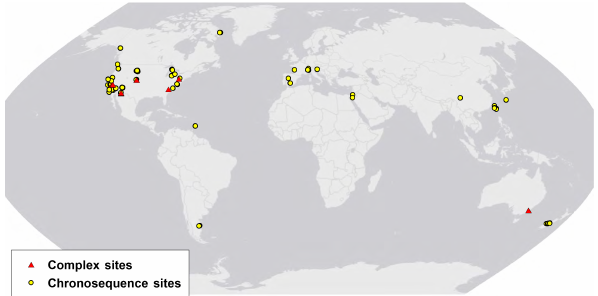
Figure 1. Map of study sites. Yellow points indicate location of chronosequences, and red triangles indicate location of soils in com- plex